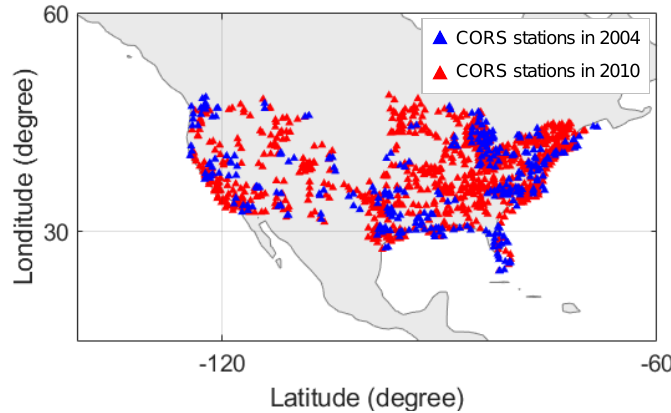
Figure 1. Continuously operating reference stations (CORS) stations in 2004 and 2010 used for the analysis in conterminous United States (CONUS) region.